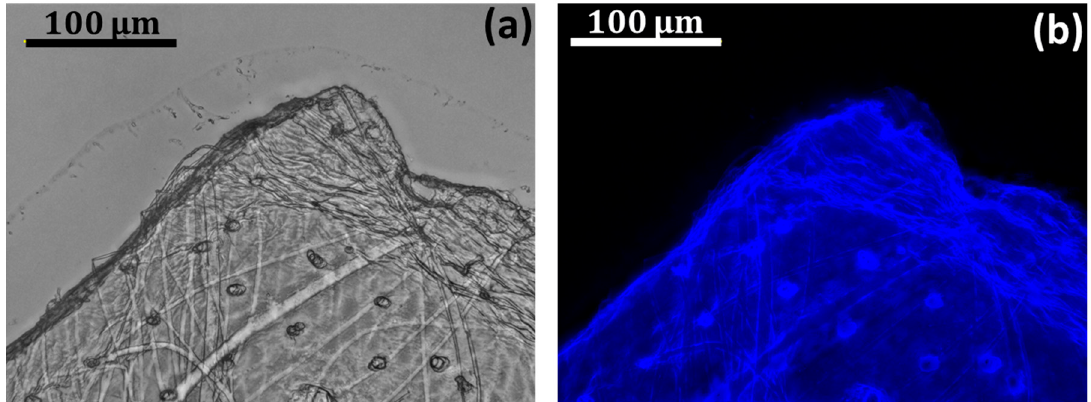
Figure 5. ( a ) Light microscopy and ( b ) fluorescence microscopy images of a selected fragment of the porous cuticle isolated from C. versicolor and stained with CFW. ( b ) Light exposure time in image: 1/6800 s.